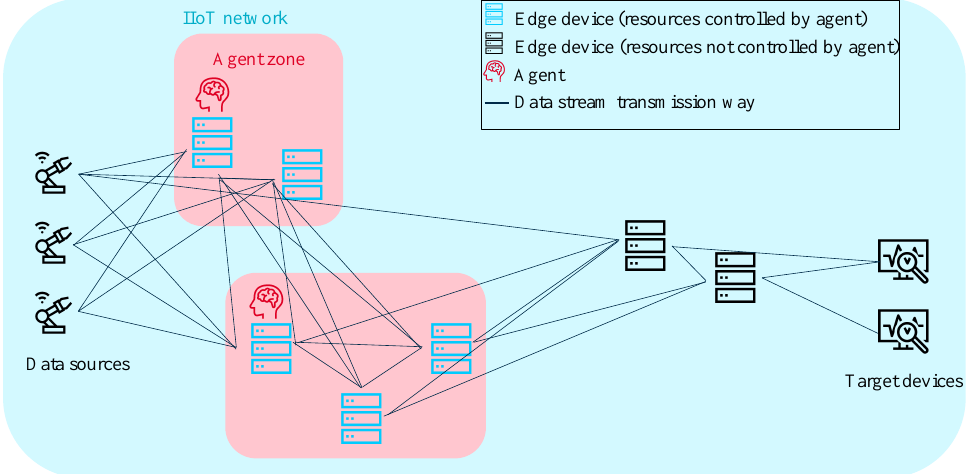
Figure 5. Schematic problem–solution approach on system level.